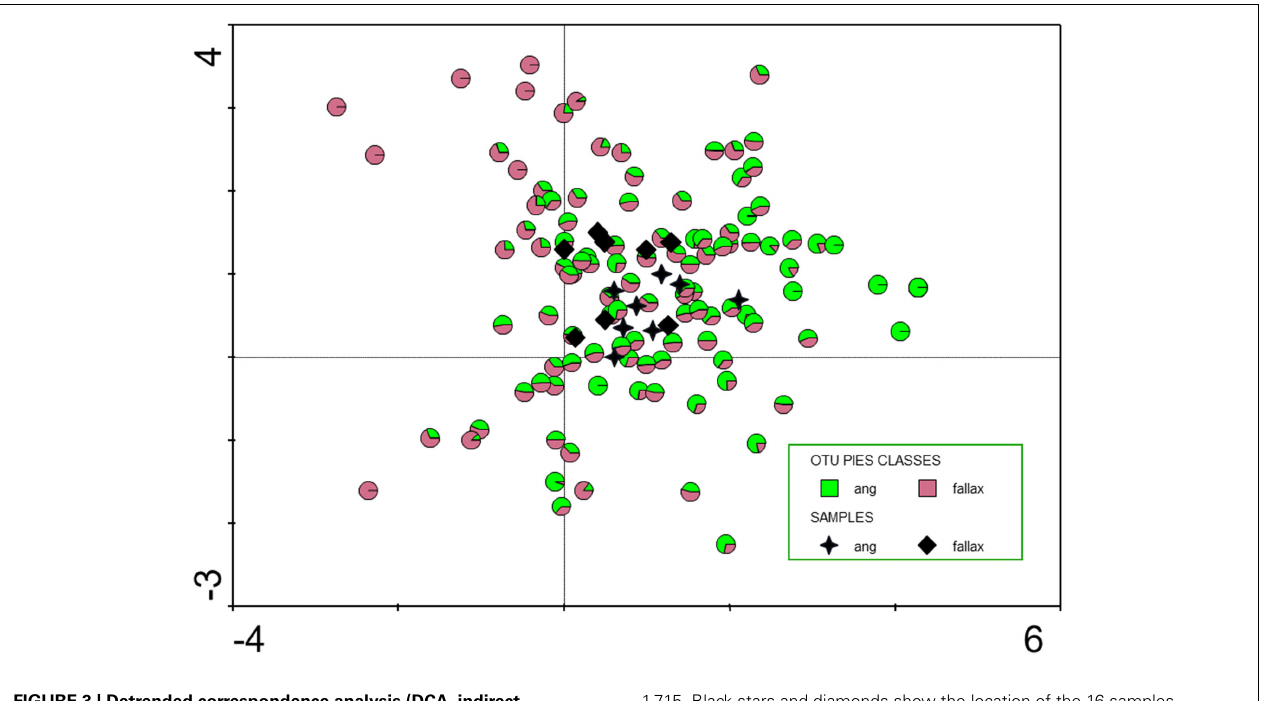
FIGURE 3 | Detrended correspondence analysis (DCA, indirect unimodal gradient analysis) of operational taxonomic units (OTUs) identified by SSCP community fingerprints. Eigenvalues of first and second axis are 0.244 and 0.141, respectively; sum of all eigenvalues